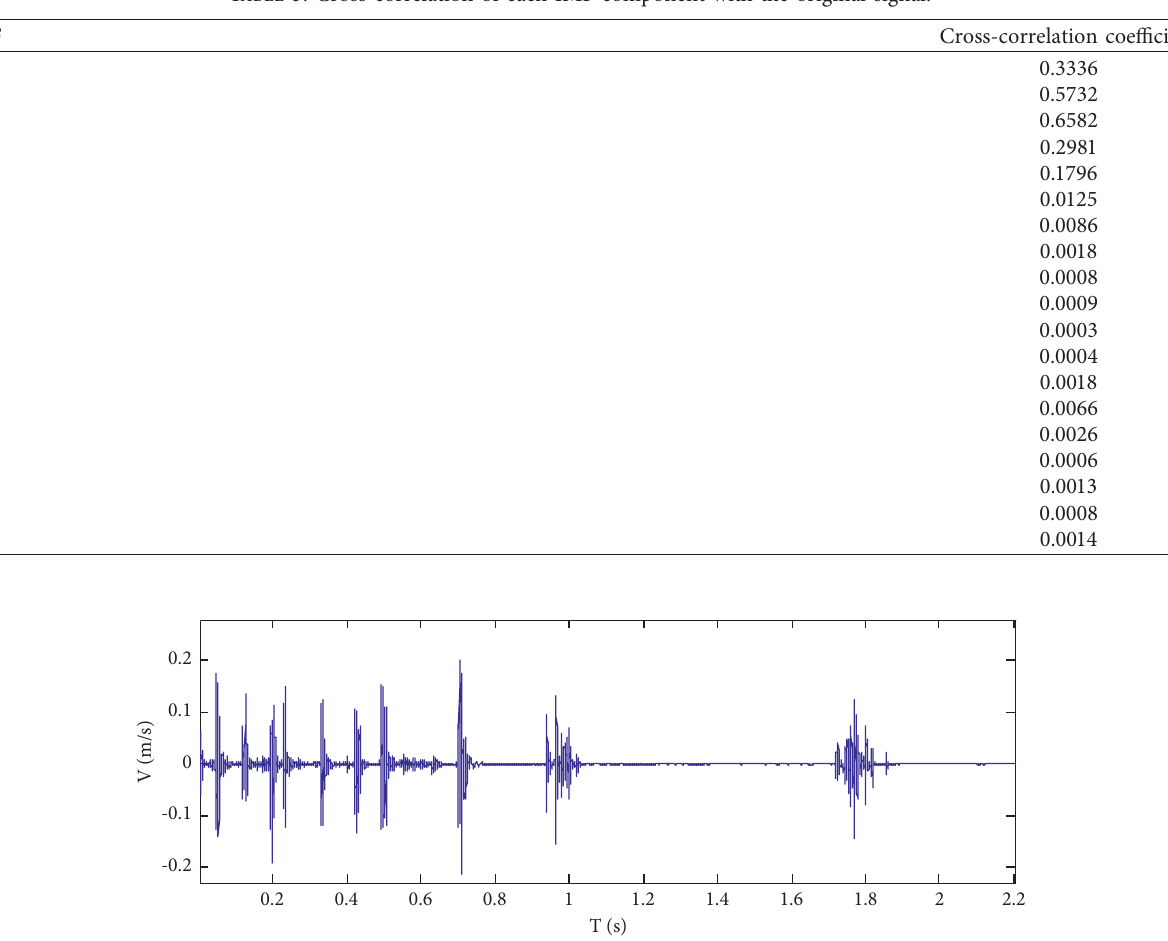
Table 3: Cross-correlation of each IMF component with the original signal.